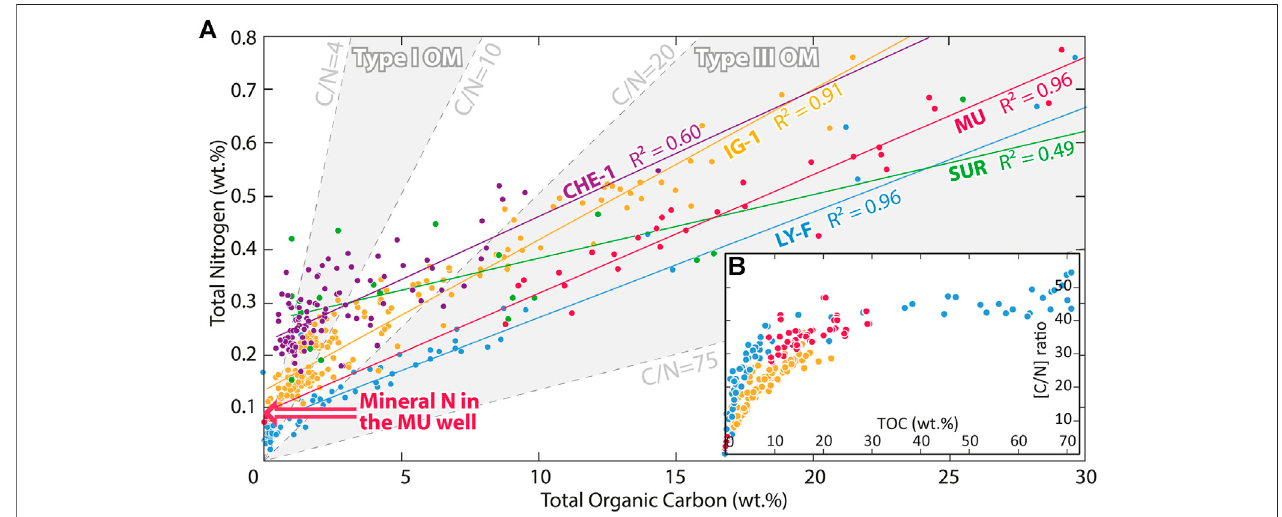
FIGURE12|(A) TNvs TOCfortheIG-1,CHE-1, MU,SUR, SUR-1,SUR-2,and LY-Fsections. Greyareasdisplay theintervalswhere points forType IandType III OM should be found if this signal is not altered by the presence of mineral nitrogen or denitri fi cation processes. The regression lines for the SUR, SUR-1, SUR-2, and CHE-1sectionscannotbeextrapolatedattheorigintocalculatethemineralnitrogen,becauseofatoolow R 2 . (B) C/NatomicratiovsTotalOrganicCarbon(TOC)forthe LY-F, IG-1, and MU wells showing an exponential pattern induced by the presence of mineral nitrogen.